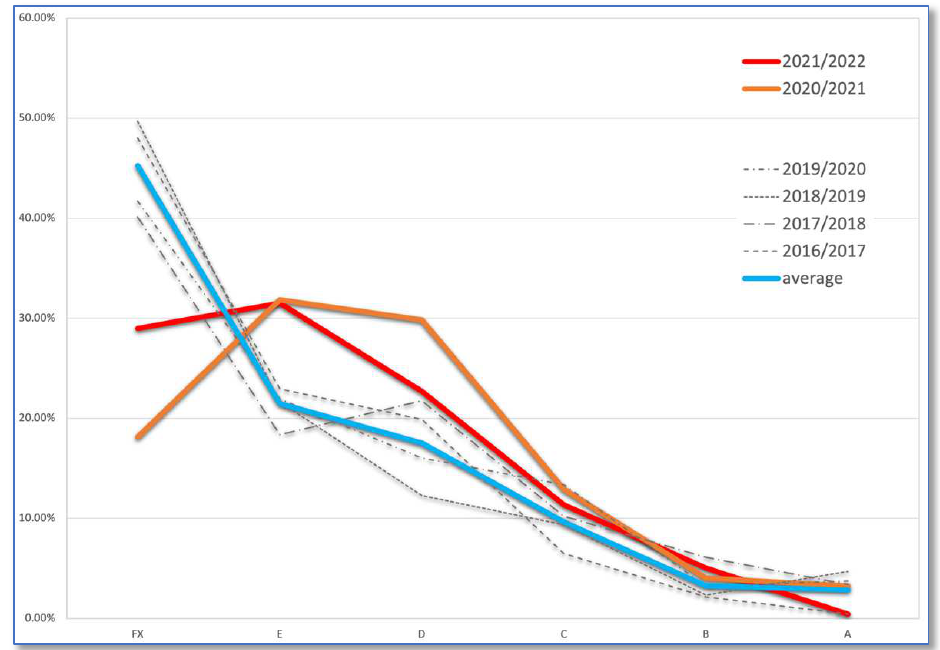
Figure 7. Distributions of grades for the last six academic years.